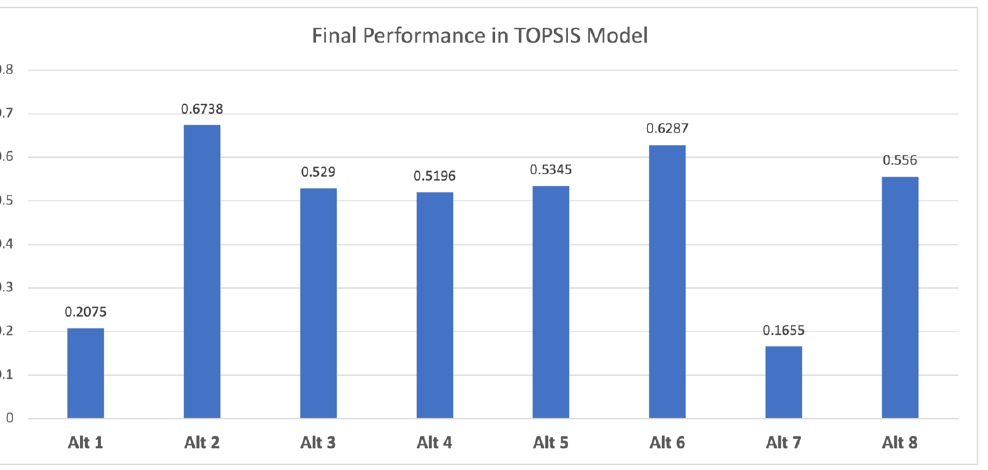
Figure 8. The final performance in TOPSIS model.